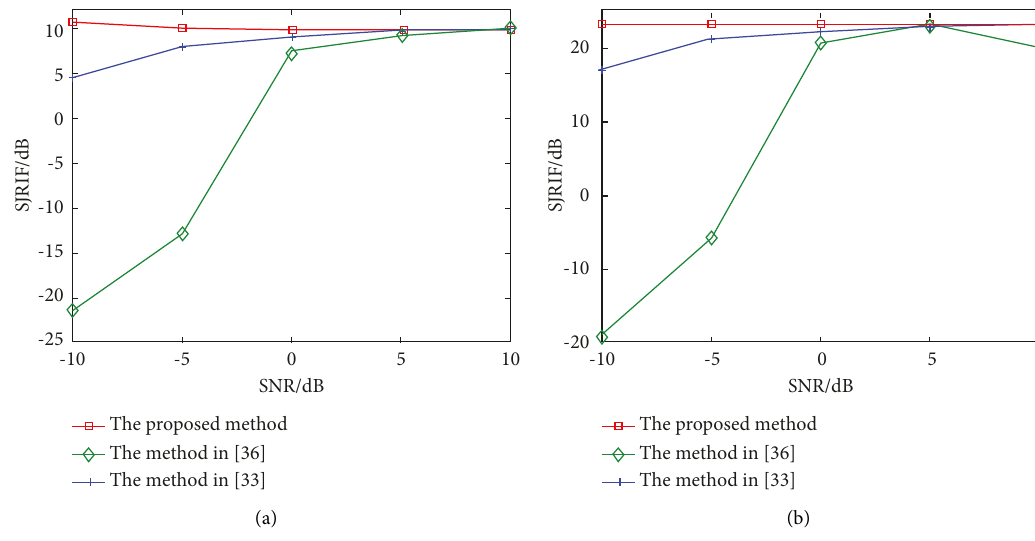
Figure 16: JSRIF variation versus SNR. (a) JSR � 5dB. (b) JSR �